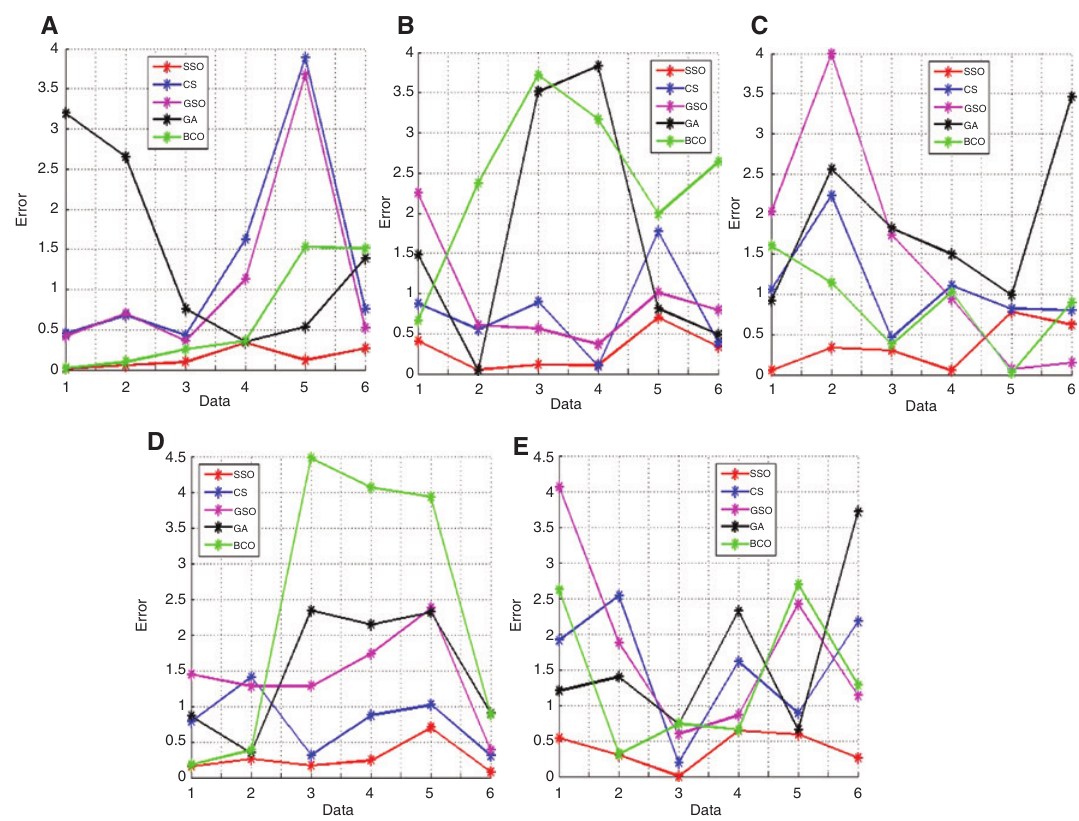
Figure 2: Error Graphs for Different Wall Temperatures. (A) Ferro-cement wall panel; (B) RCC wall panel; (C) combined ferro-cement and RCC wall panel; (D) combined two ferro-cement wall panels and (E) combined two RCC wall Table 1: Ferro-Cement Wall Panel. Input